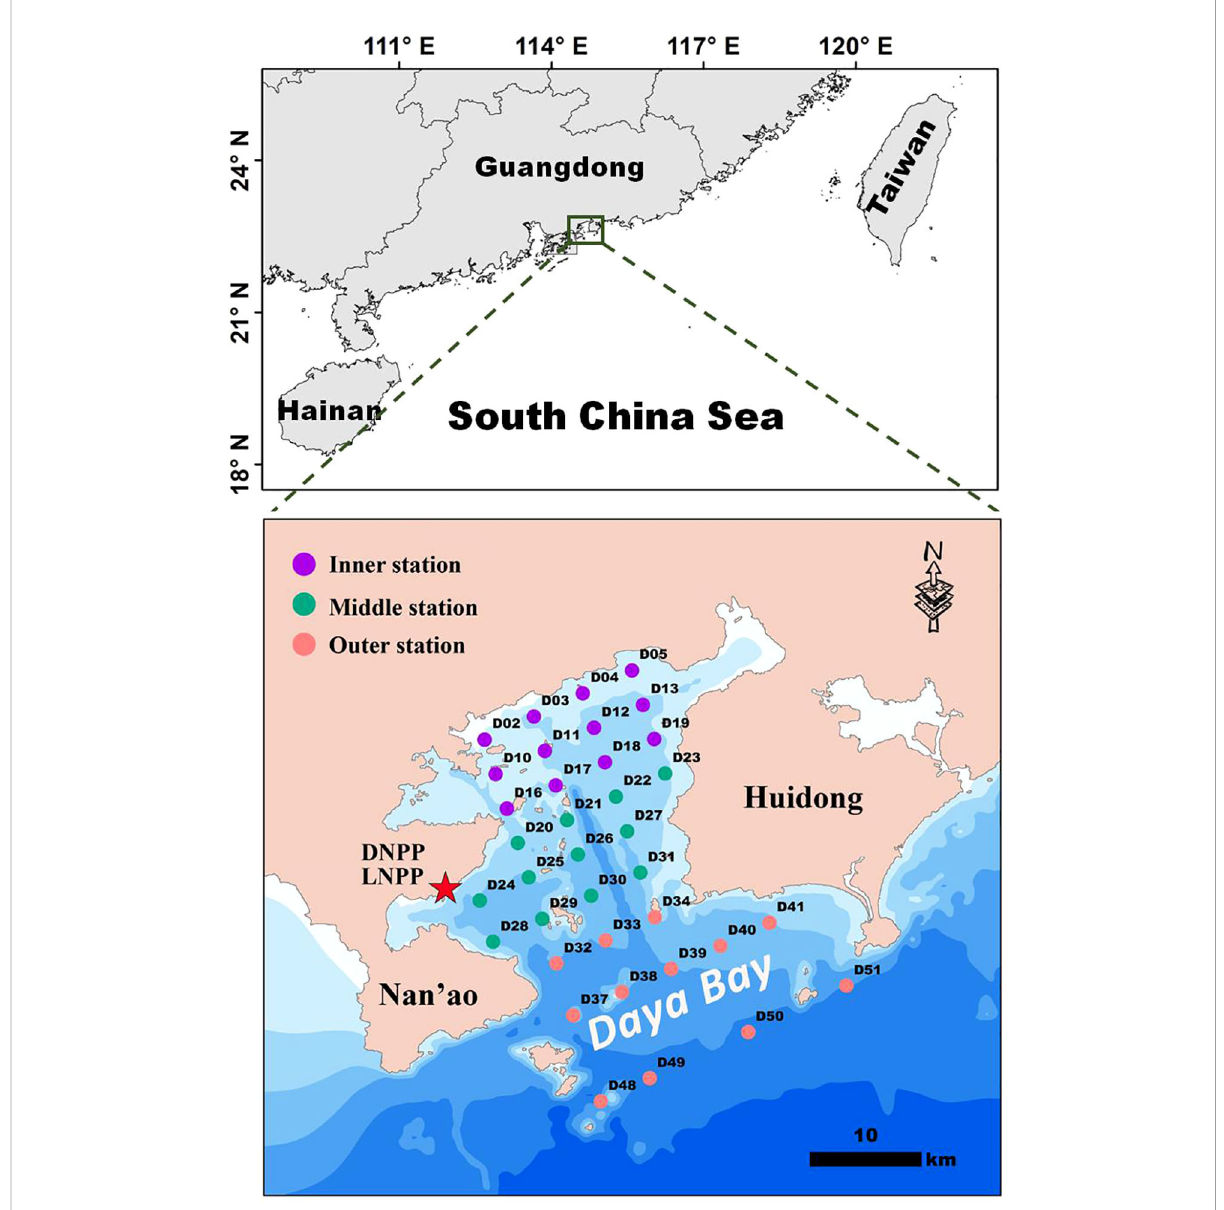
FIGURE 1 Schematic diagram of benthic macrofaunal sampling stations in the Daya Bay Subtidal zone. Stations are divided into three sectors: inner (purple circle, n = 12), middle (green circle, n = 12) and outer (orange circle, n = 12). DNPP, Daya Bay Nuclear Power Plant; LNPP, Ling ’ ao Nuclear Power